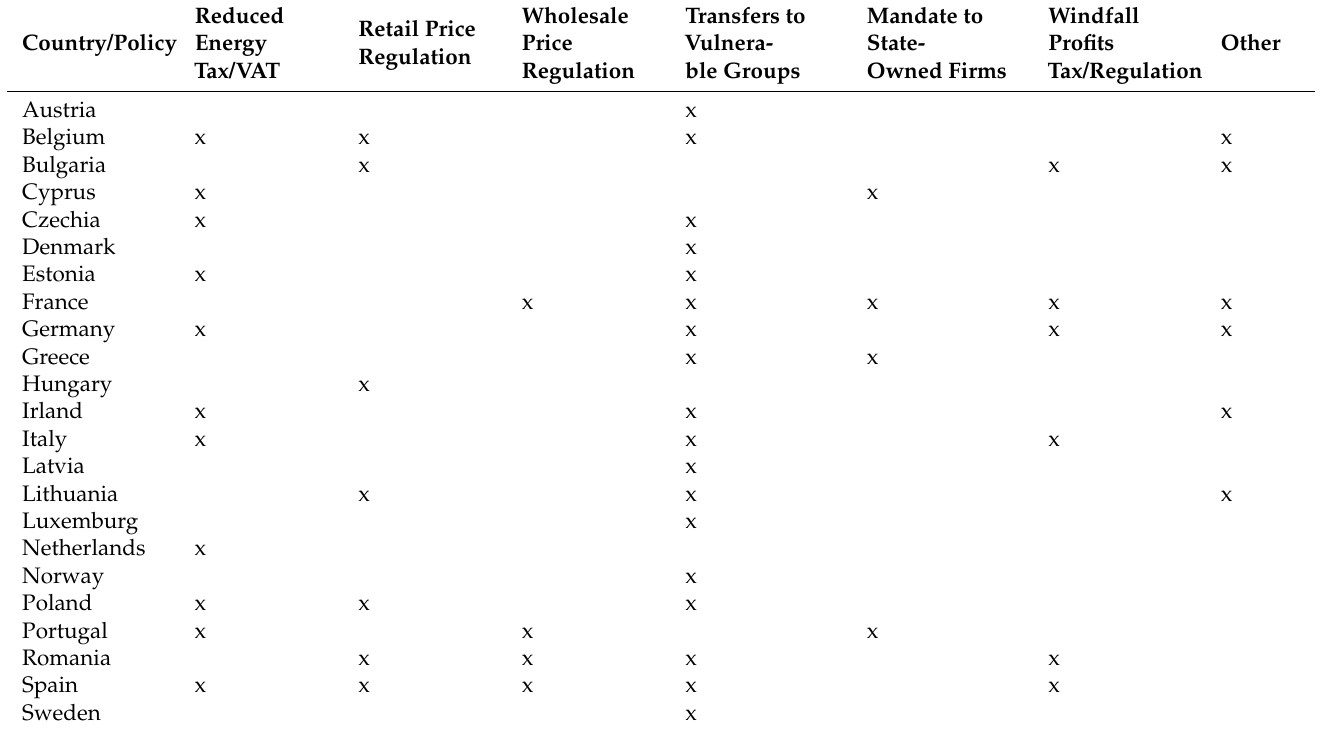
Table 2. National Policies to Shield Consumers from Rising Energy